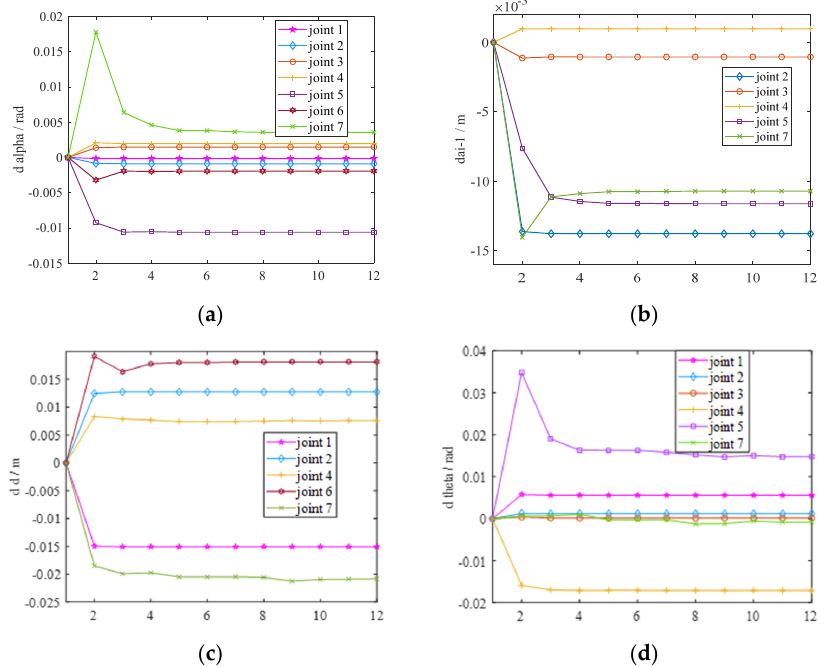
Figure 10. Identification of various parameters after the elimination of redundancy error: ( a ) δ a i − 1 ; ( b ) δα i − 1 ; ( c ) δ d i ; ( d ) δθ i . As observed, each error term can be accurately identified after eliminating redundancy error, and the identification process is stable and converges in about ten generations. As a comparison, the variation of each error item in the identification process without eliminating redundancy error is shown in Figure 11.